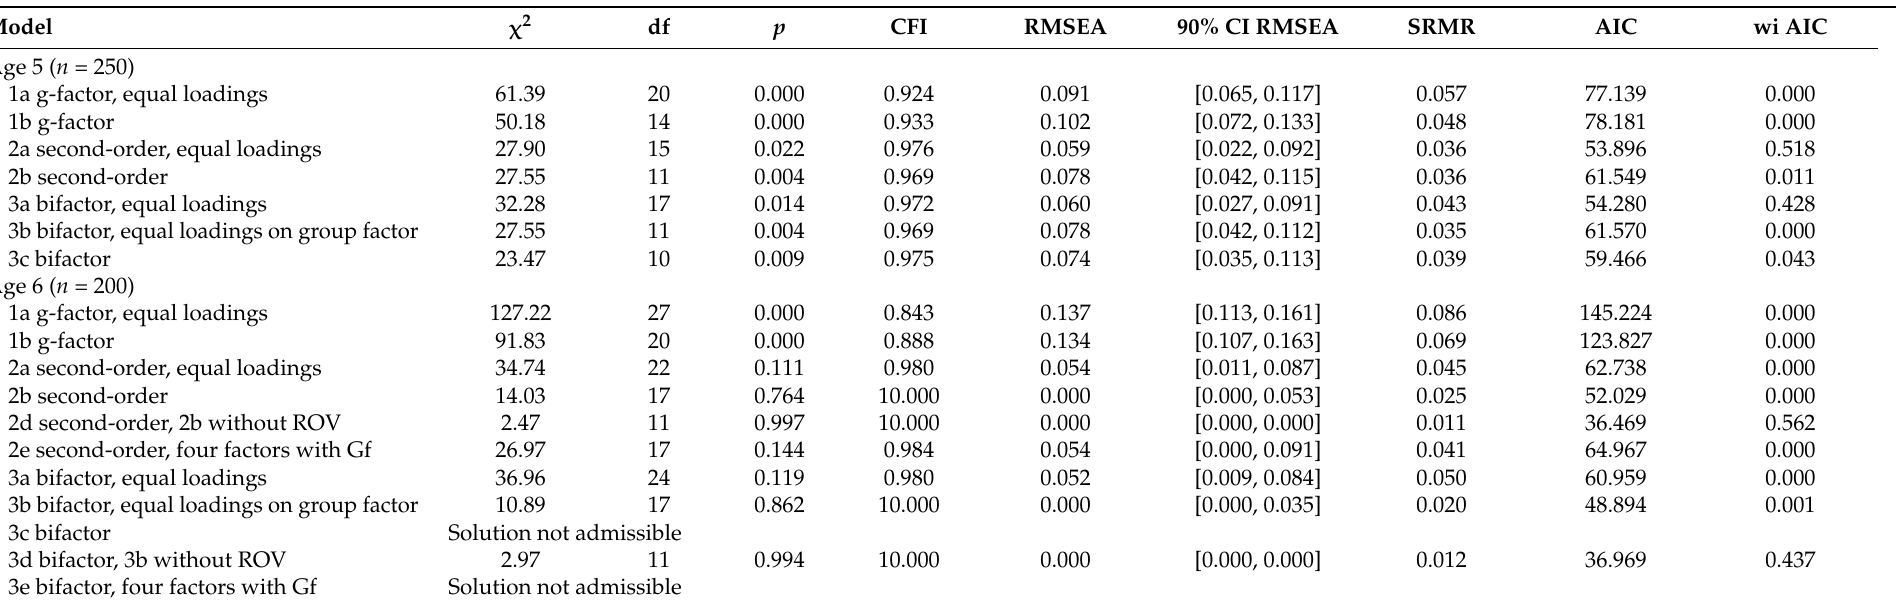
Table 10. Confirmatory factor analysis fit statistics for KABC-II core subtest Luria